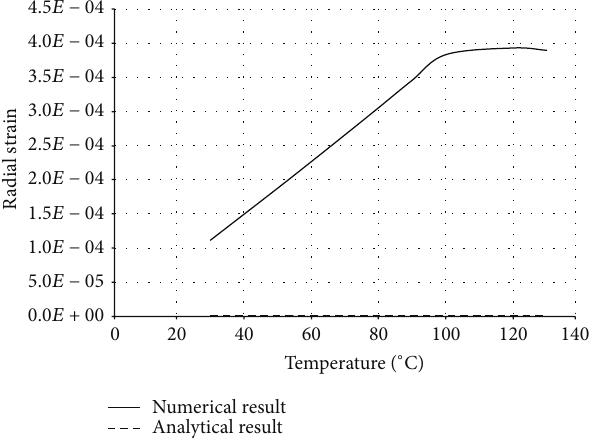
Figure 23: Comparison of radial strain in steel casing.